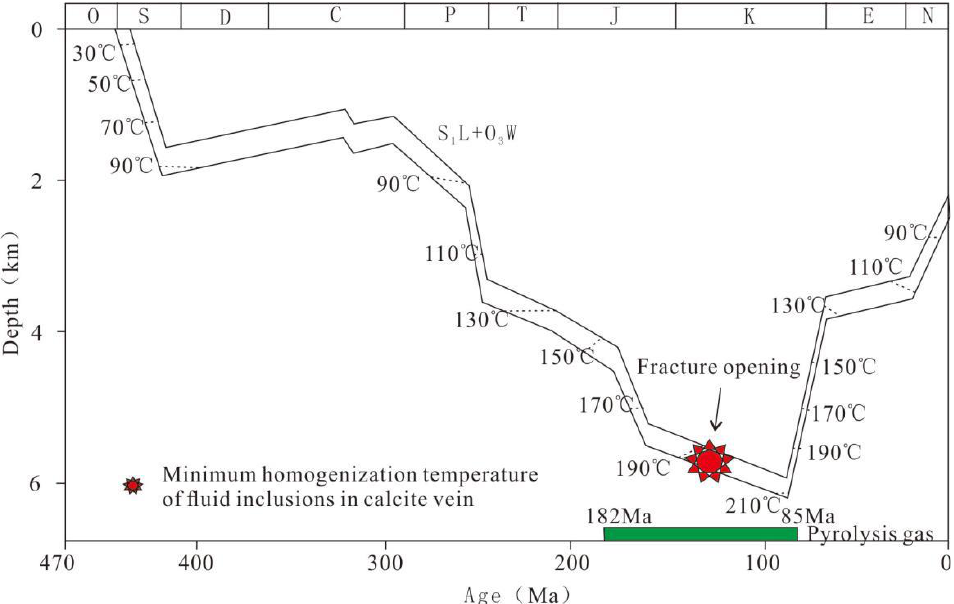
Figure 9. Comparison of minimum homogenization temperature and burial history of calcite vein fluid inclusions in Well JY1 (Modified from Gao et al [12]).